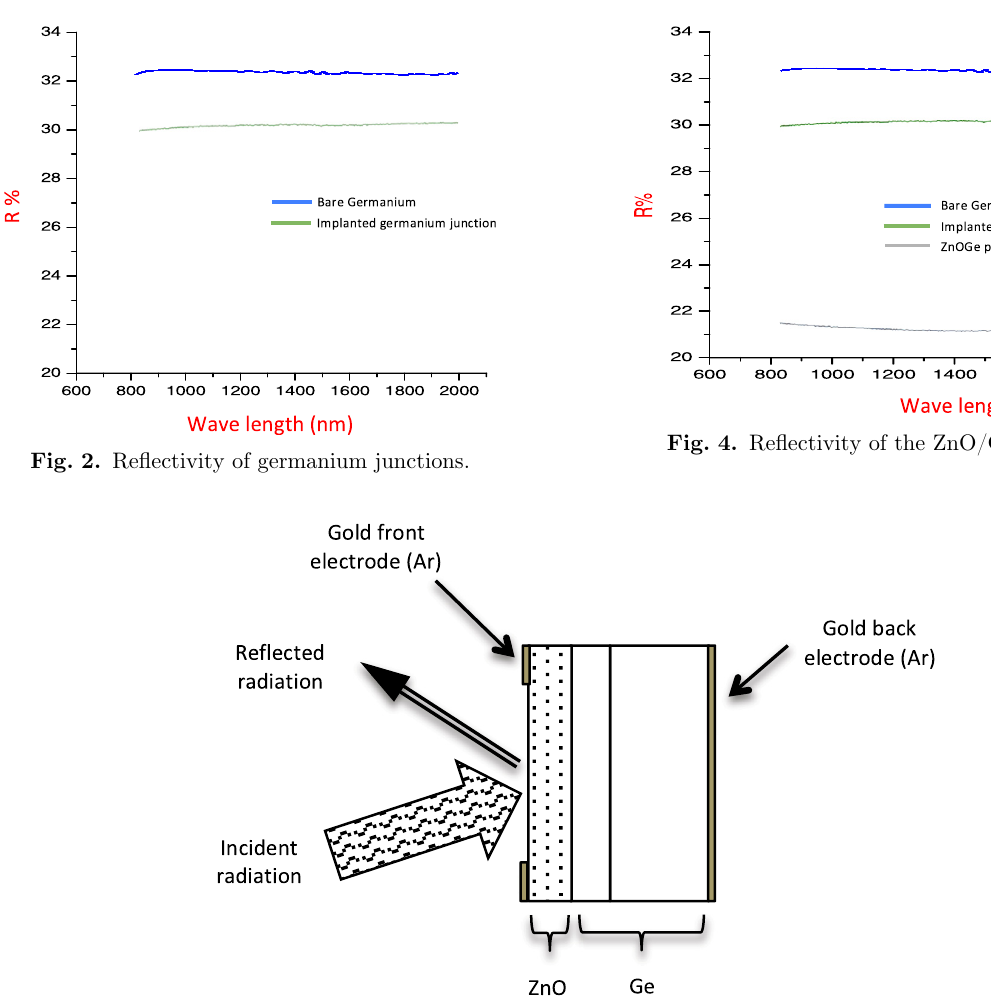
Fig. 3. Structure of the ZnO/Ge photodiode.